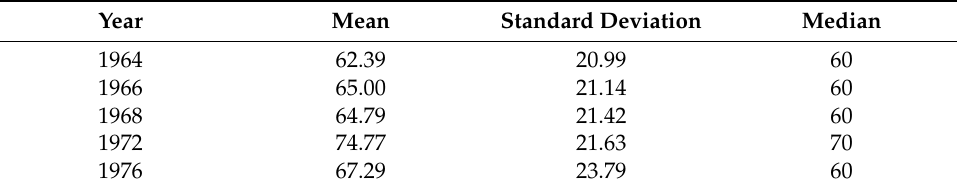
Table 1. Trends in Jewish feeling thermometer ratings based on the American National Election Studies (ANES),